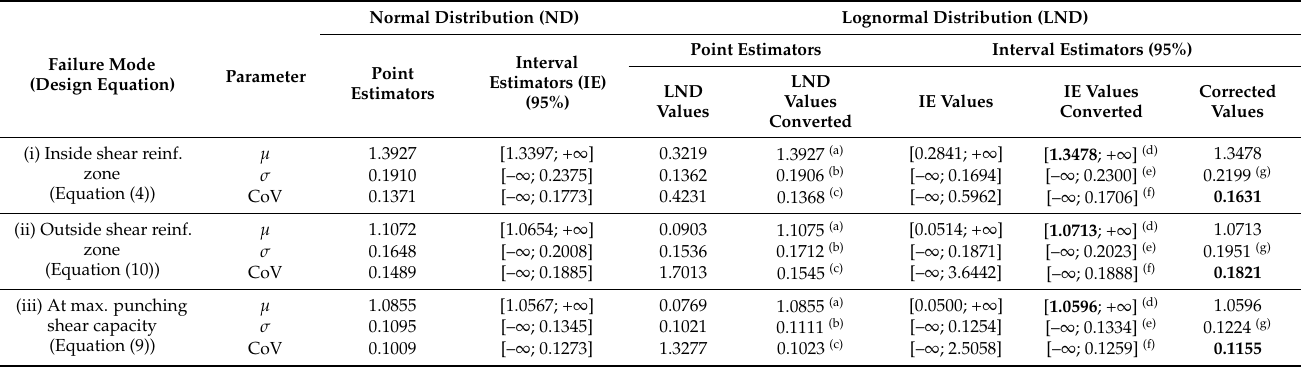
Table 2. Statistical parameters for the model uncertainty.